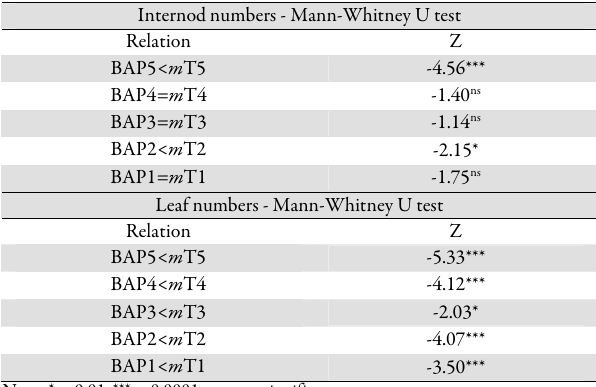
Tab. 4. The internod and leaf numbers analyses between the two cytokinin treatments in multiplication experiment